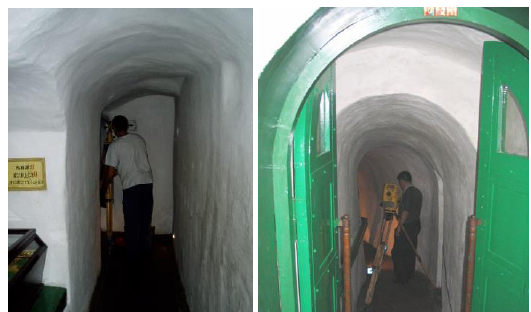
Fig. 4. Scanning stations georeferencing by free station